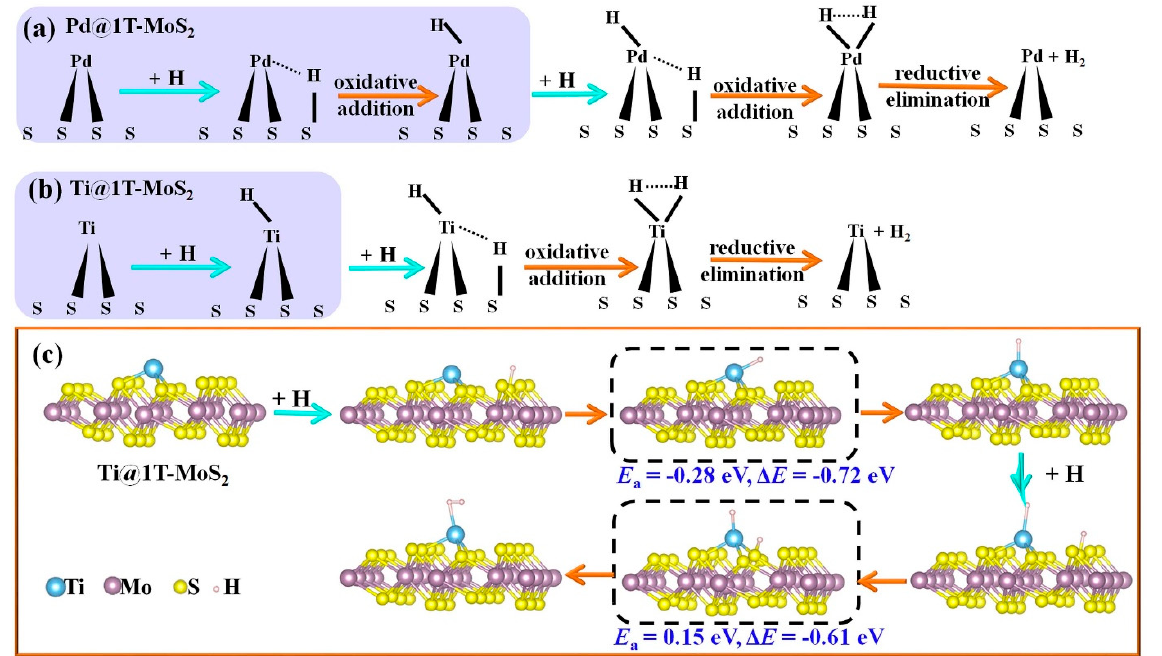
Figure 4. ( a ) Schematic of HER mechanism on Pd@1T-MoS 2 . ( b ) Schematic of HER mechanism on Ti@1T-MoS 2 and ( c ) the corresponding minimum-energy pathways via Volmer-Tafel route. The transition state is marked with a dashed frame. The activation energy barrier ( E a ) and reaction energy ( Δ E , total energy change between product and reactant) are shown below the dashed frame.